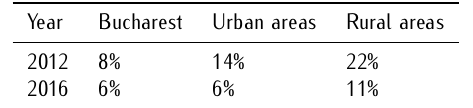
Table 2. Open access networks in 2012 vs 2016